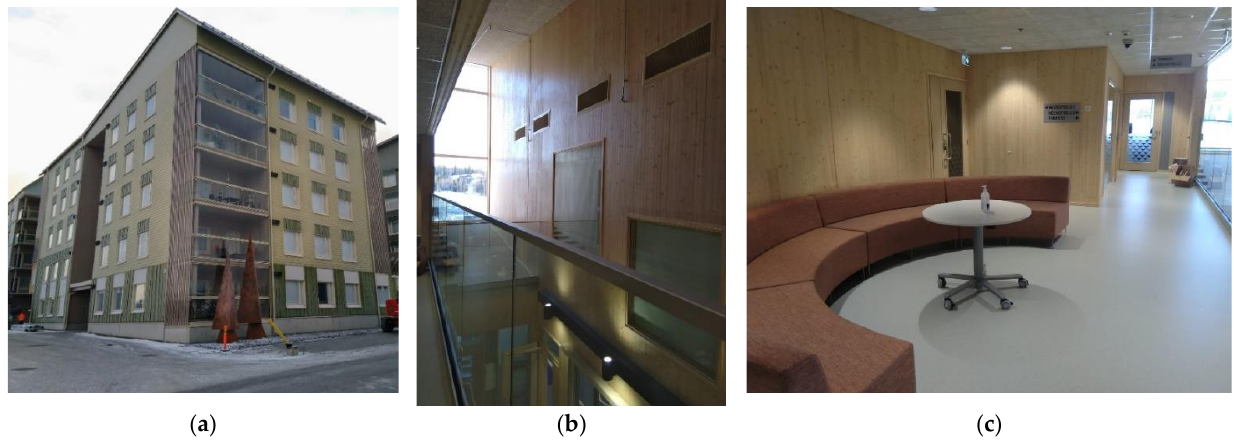
Figure 10. TOAS — Kauppi, Kuntokatu 11 A: ( a ) exterior view (photo by Hüseyin Emre Ilgın); ( b , c ) interior views (photos courtesy of Suomen metsäkeskus).